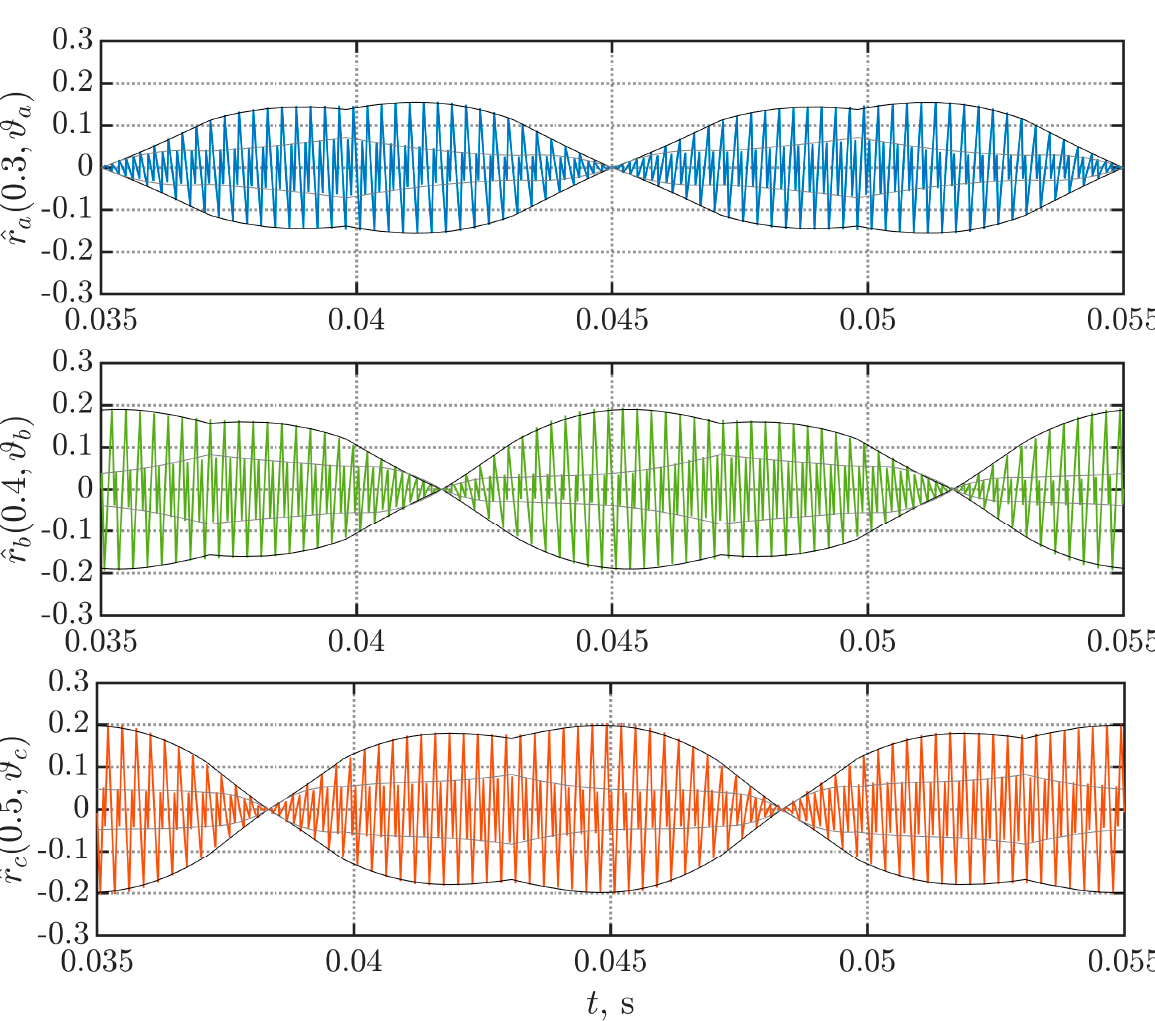
Figure 6. Normalized phase current ripples in case of modulation index unbalance ( m a = 0.3, m b = 0.4, m c = 0.5) with primary (black) and secondary (gray) envelopes for centered PWM.